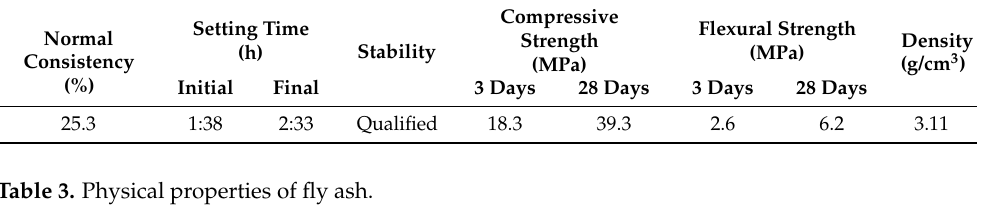
Table 2. Basic properties of cement.